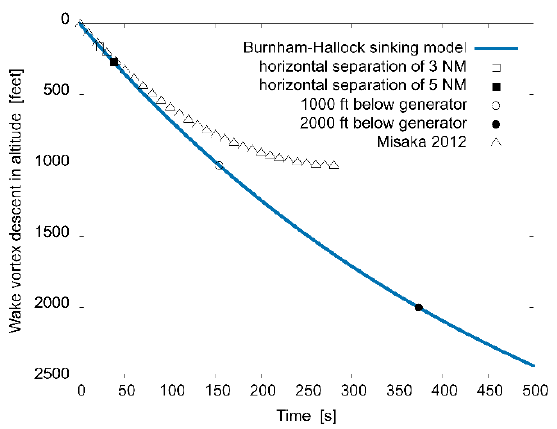
Figure 8. Wake vortex descent in altitude h WV vs. time t from the Burnham-Hallock model [34], and data for ε ∗ = 0.01 and N ∗ = 0.00 [24], for the A380-861 aircraft.